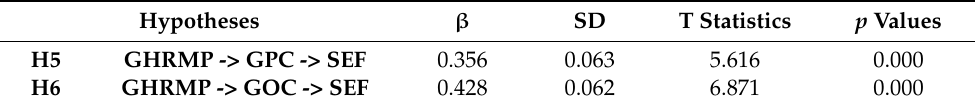
Figure 3. Mediator analysis. Table 7. Mediator